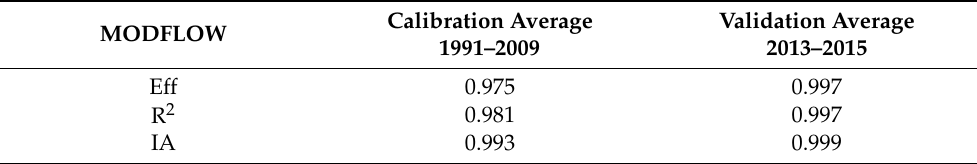
Table 7. Summary efficiency statistics of the MODFLOW